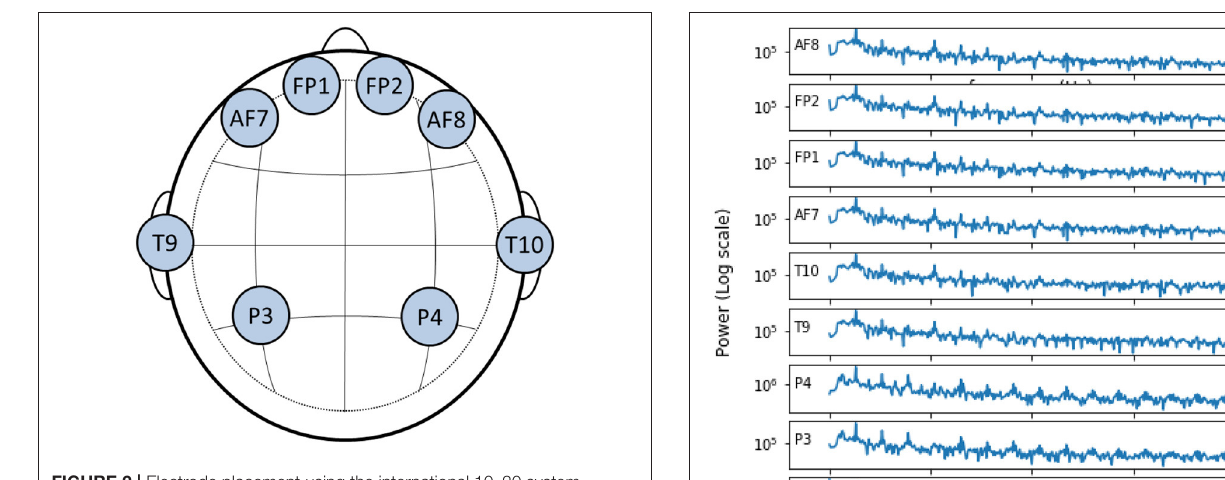
FIGURE 2 | Electrode placement using the international 10–20 system.